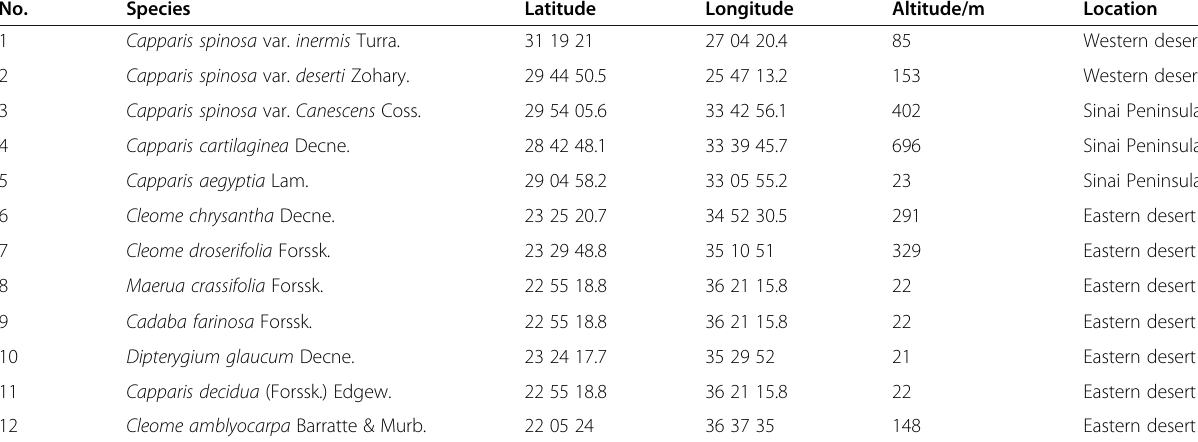
Table 1 A list of selected Capparaceae and Cleomaceae species used in this study with ISSR, SRAP, and ISTR primers showing their locations and co-ordinates